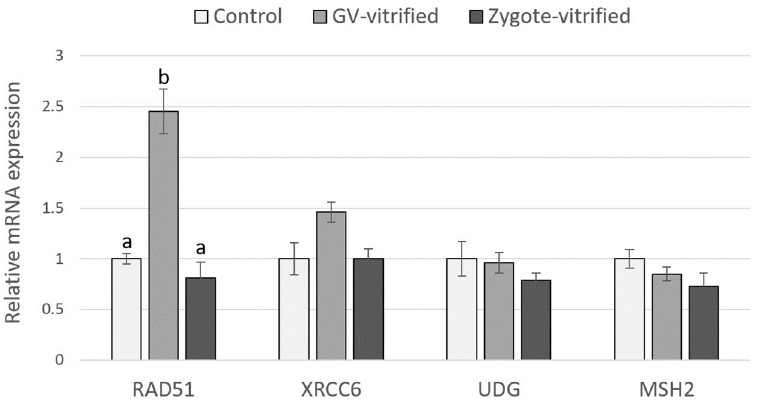
Fig 4. Relative mRNA expression of DNA-repair genes in 4–8 cell stage embryos obtained either without vitrification (Control) or after oocyte vitrification at the GV-stage (GV-vitrified) or after zygote vitrification (Zygote-vitrified). Data are shown as the mean ± SEM. Values with different superscripts (a and b) among treatment groups differ significantly (P < 0.05). The experiment was replicated three times.